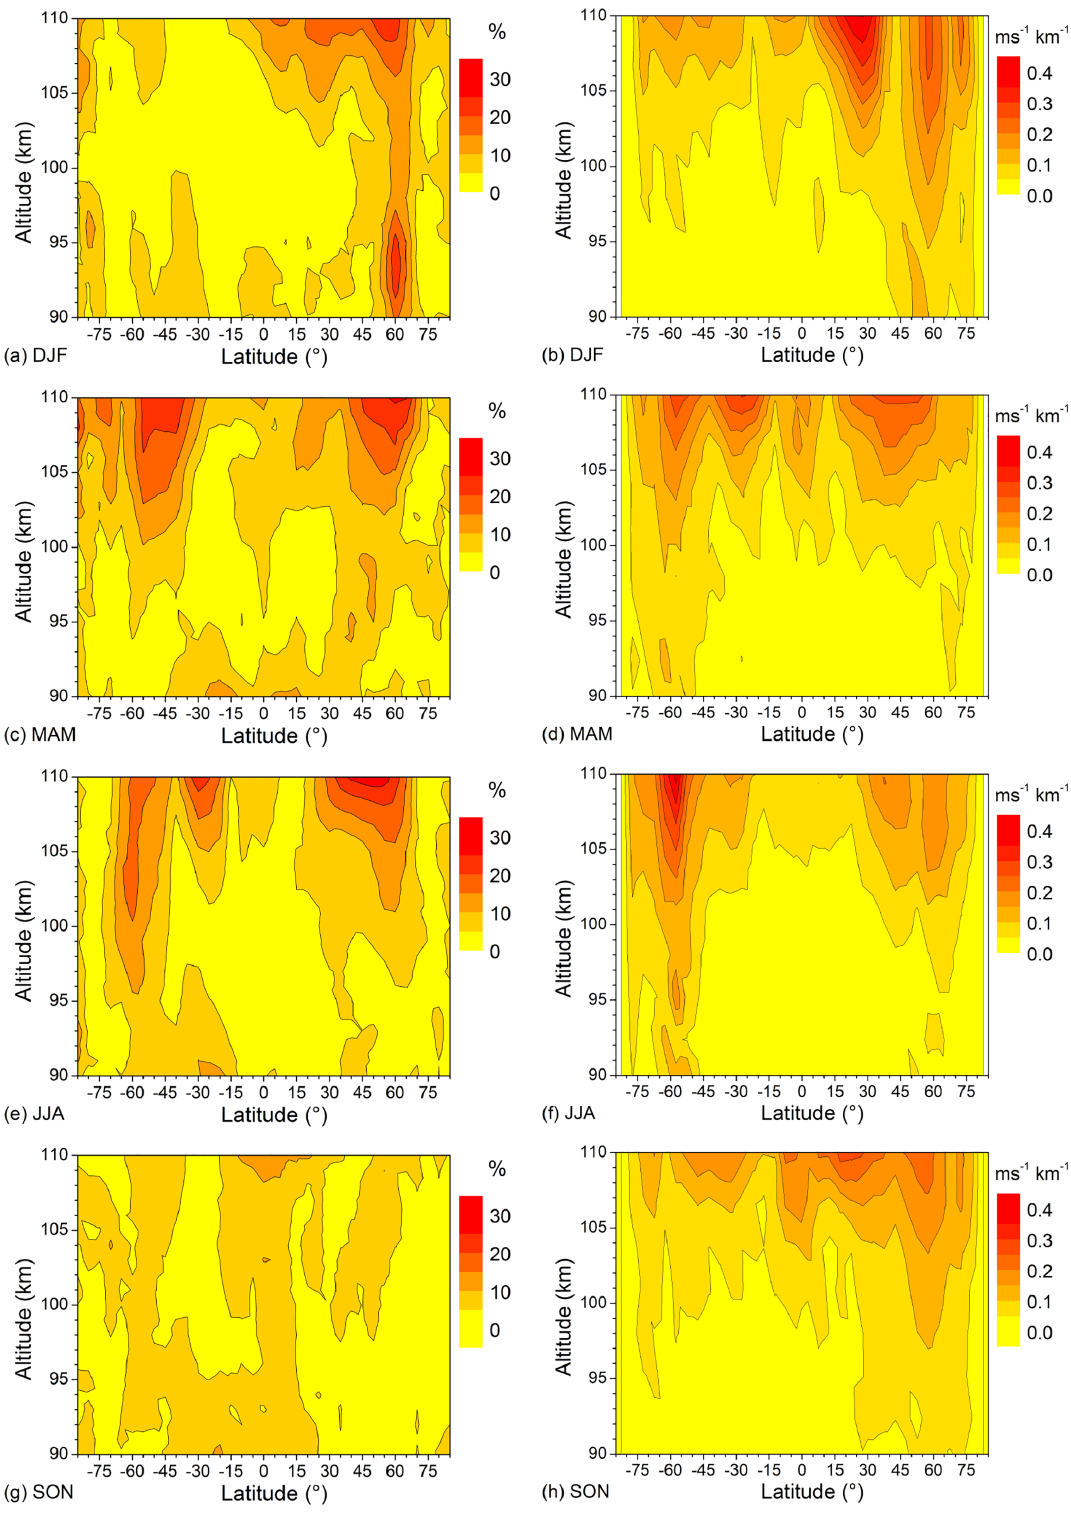
Figure 8. Left column: 2007–2016 mean monthly mean QDT Es relative amplitudes for (a) DJF, (c) MAM, (e) JJA, and (g) SON. Right column: corresponding MUAM QDT component of zonal wind shear for (b) DJF, (d) MAM, (f) JJA, and (h)